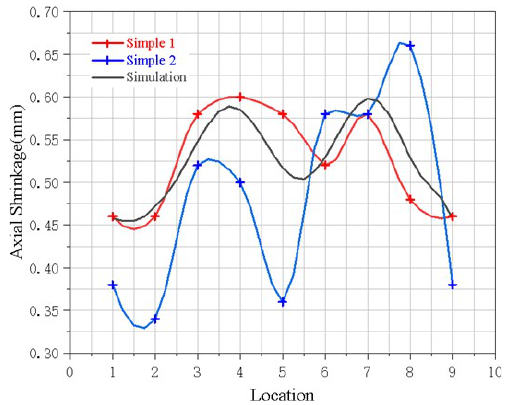
Figure 6. Welding